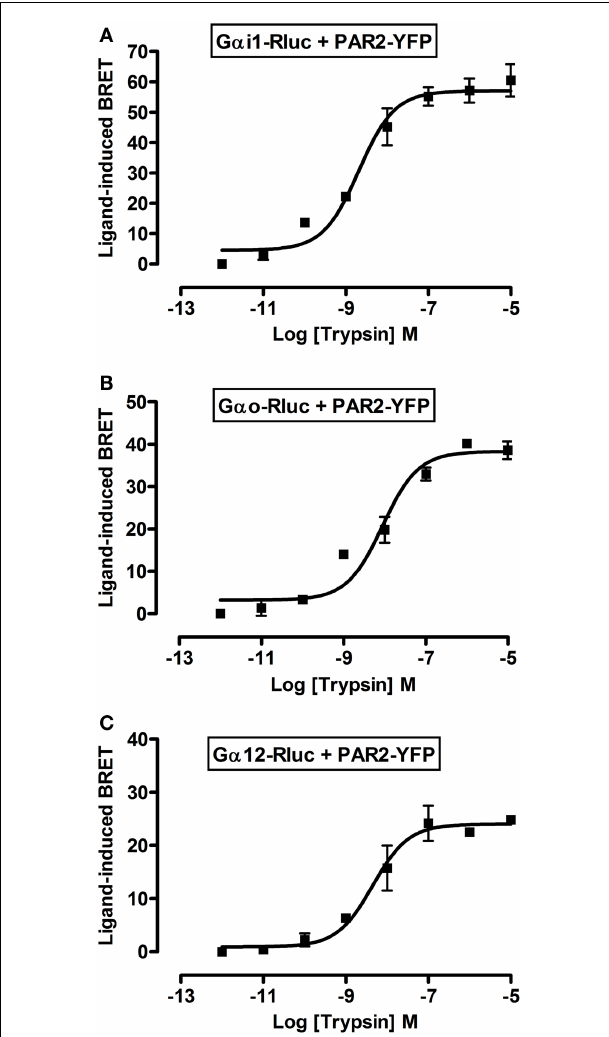
FIGURE 5 | Dose-response analysis of SLIGRL-induced BRET increase between PAR2 and G α proteins . COS-7 cells transiently co-expressing PAR2-YFP and either G α i1-Rluc (A) , G α o-Rluc (B) , or G α 12-Rluc (C) were used for BRET experiments in the presence of increasing concentrations of SLIGRL as indicated. Data are means ± SEM of three to four independent experiments performed in